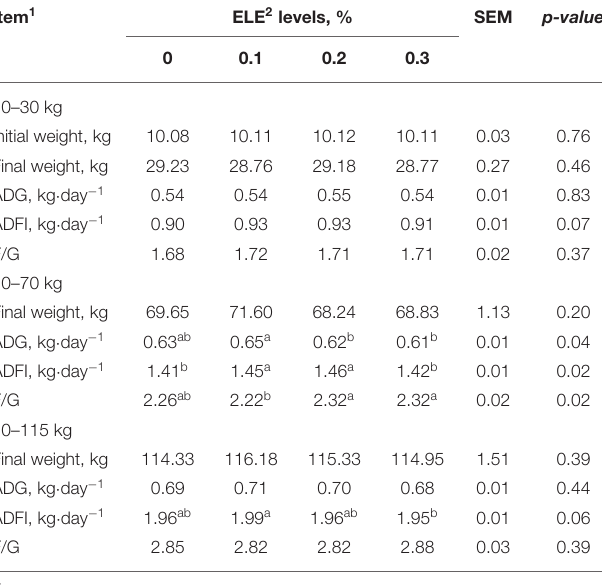
TABLE 2 | Primers used for quantitative real-time PCR. Genes a